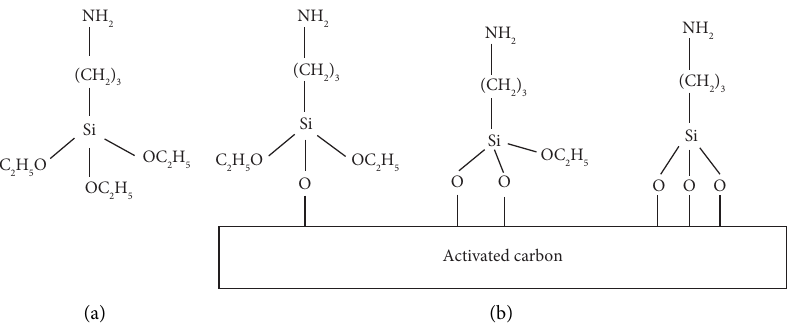
Figure 3: Schematic representation of APTES modifcation of AC: (a) APTES molecule and (b) APTES on the AC’s surface.